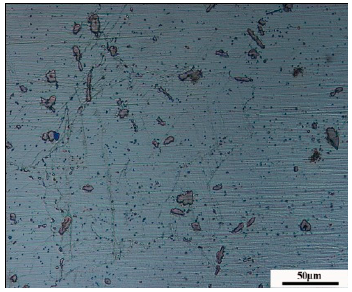
Figure 4. Optical micrographs of AZ91-1.0%Pr alloy after solution treated.